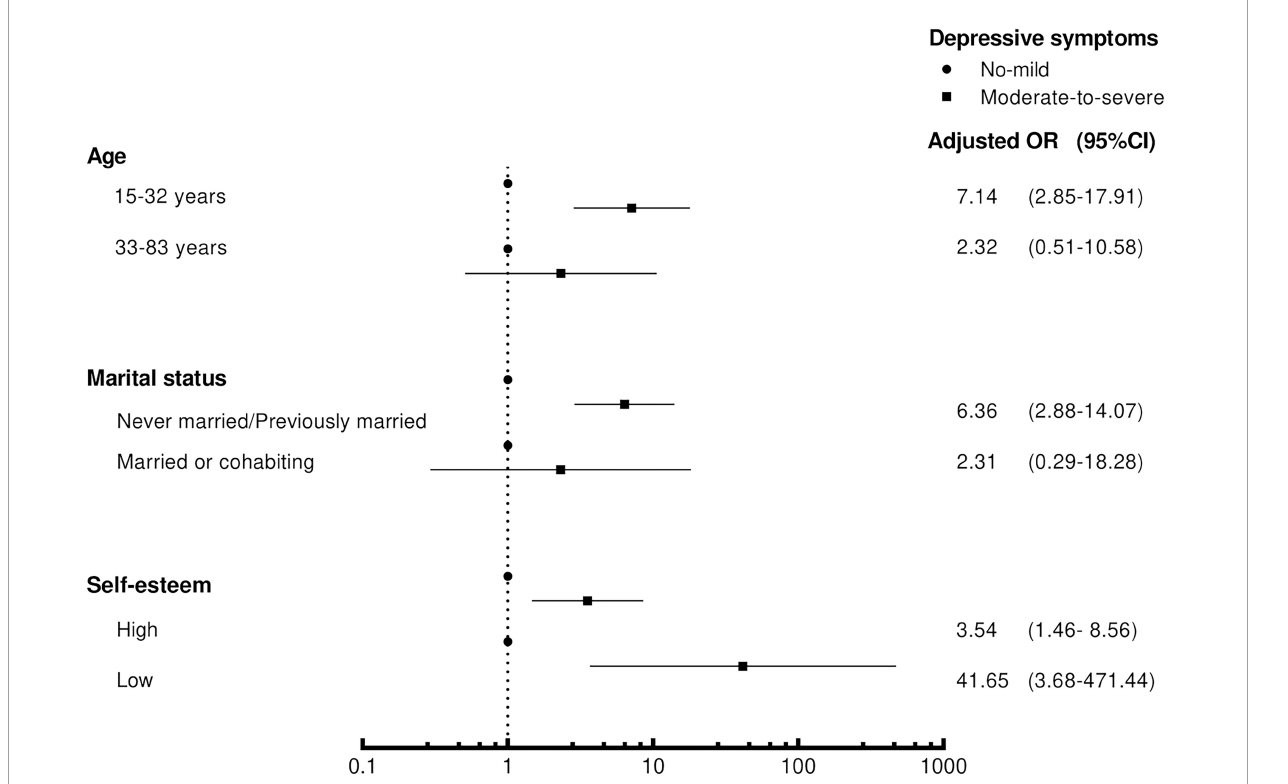
FIGURE1 The effect sizes in the association between depressive symptoms and loneliness stratified by age, marital status and self-esteem in logistic regression. The models were adjusted for the variables in Table 2